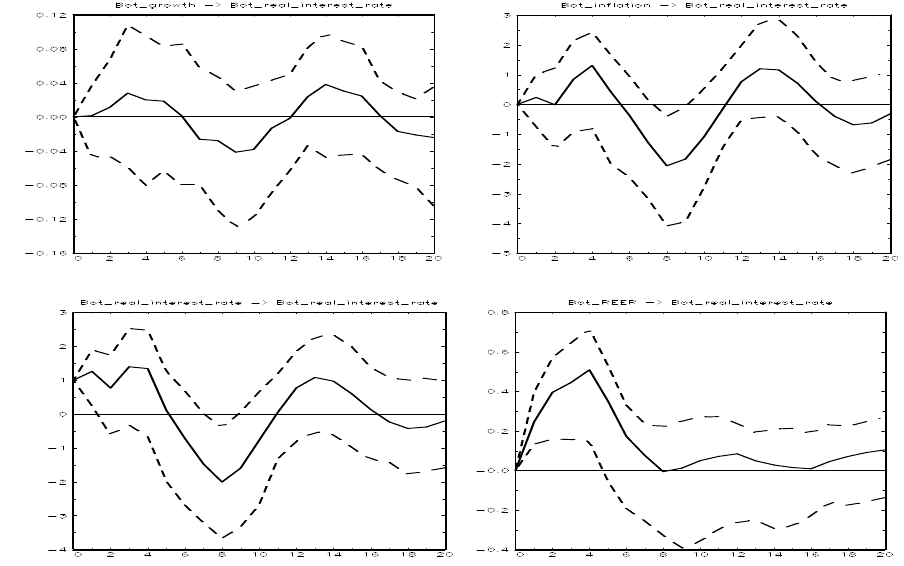
FIGURE 3: Impulse-response functions for Botswana (real interest rate